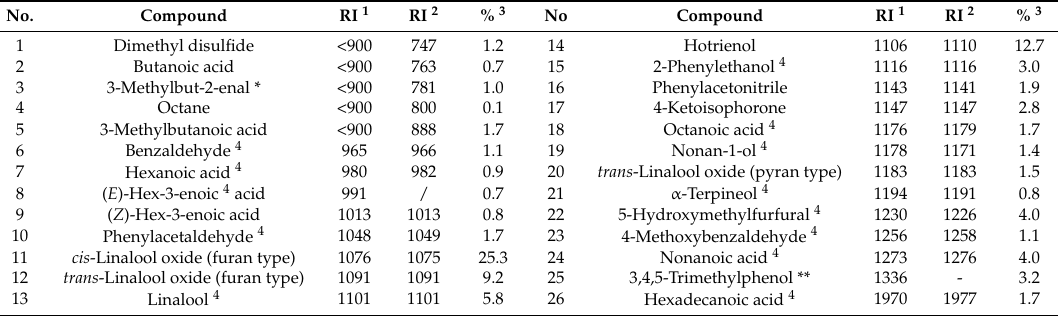
Table 1. The Headspace volatiles of the sample determined by HS-SPME/GC-MS. No.